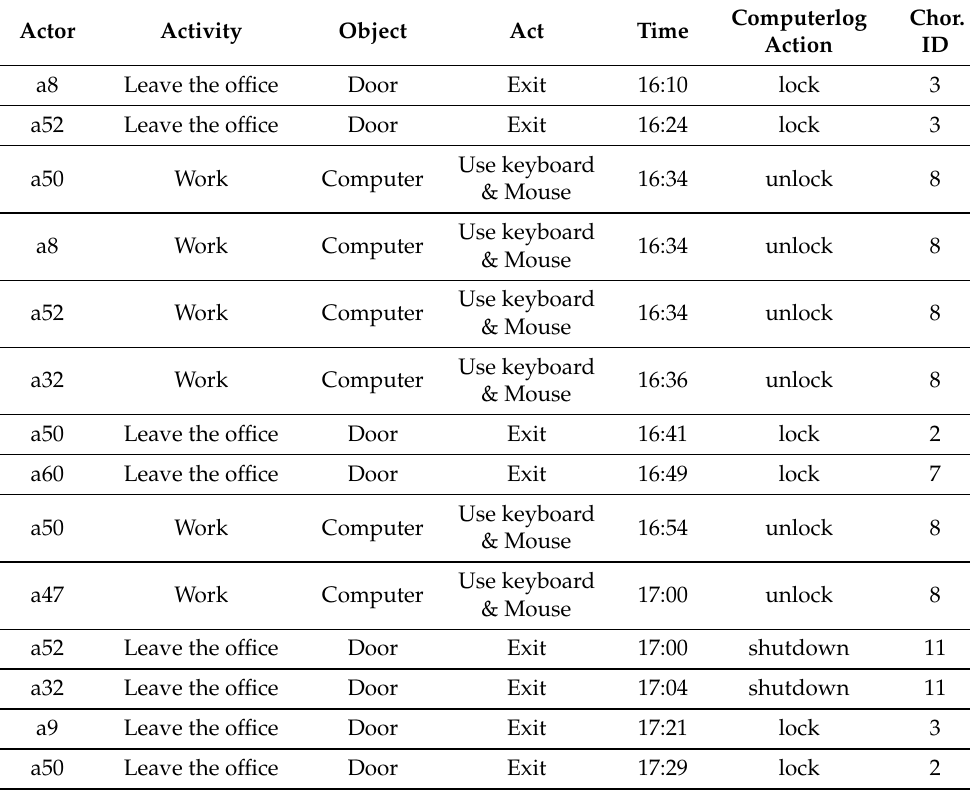
Table 7. Choreography identification for each observation with computer log action example.